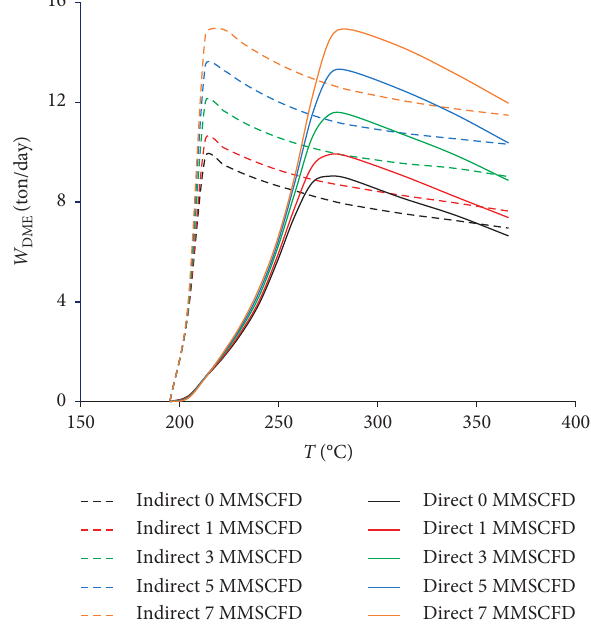
Figure 6: Effects of reactor temperature, T , at a pressure of 40 bar in the indirect and the direct processes on the DME production, W DME , at various unreacted gas recycle